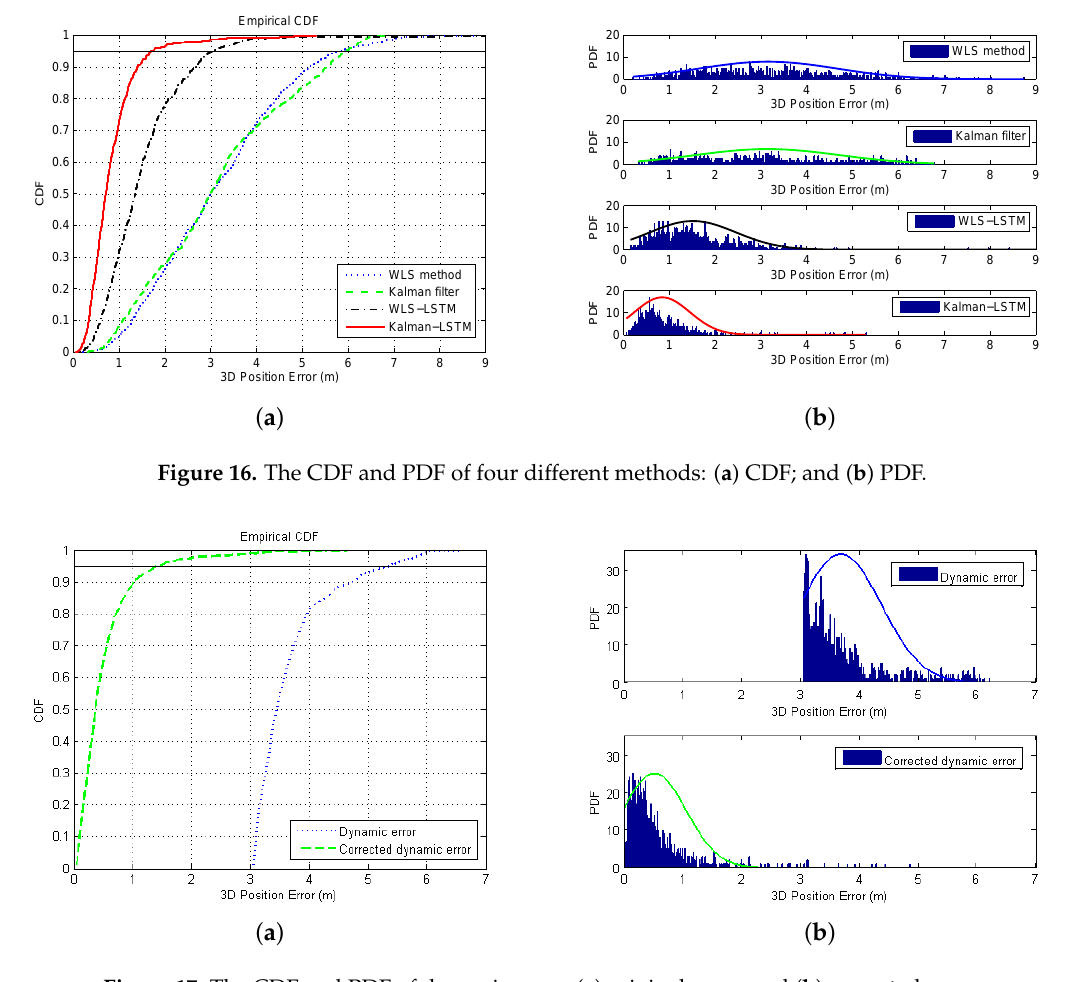
Figure 17. The CDF and PDF of dynamic error: ( a ) original error; and ( b ) corrected